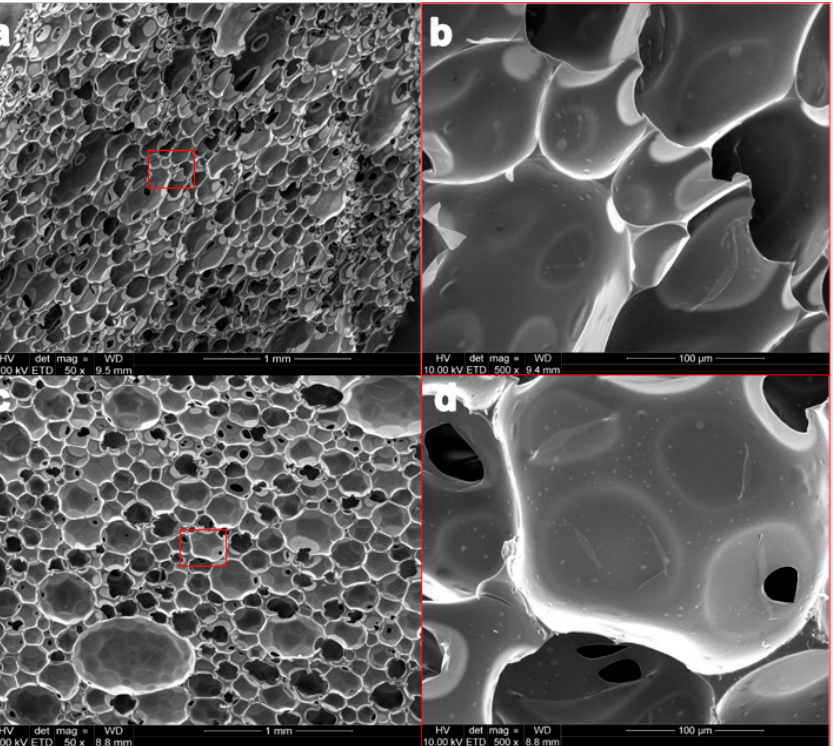
Figure 3. SEM images of PUR ( a , b , where b shows the fragment from the red selection of image a ) and PUR+Ch2 foam ( c , d , where d shows the fragment from the red selection of image c ). Table 2. Open cell content (with standard deviation SD) of PUR and PUR+Ch